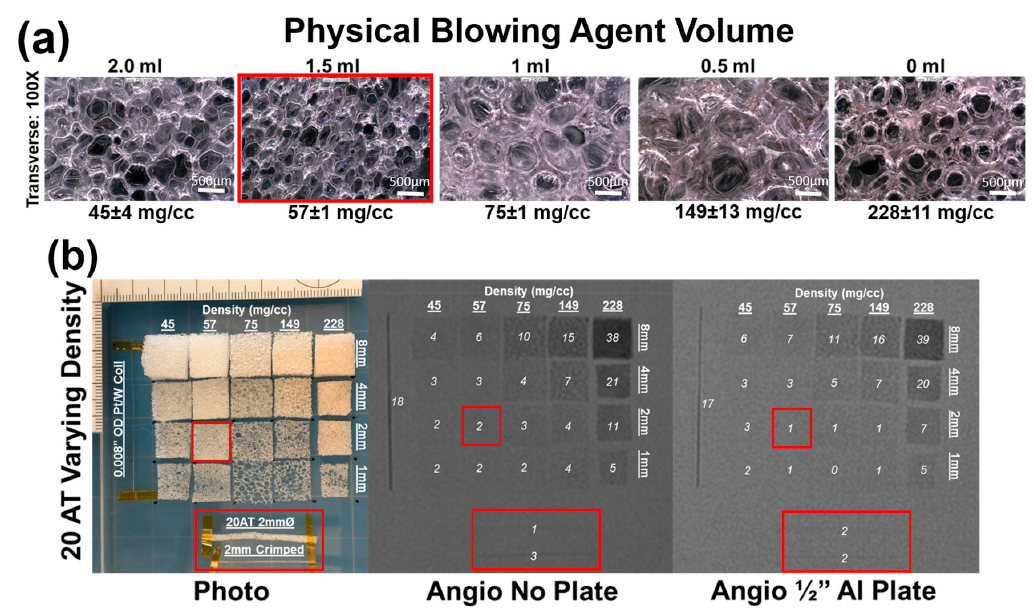
Figure 5. ( a ) Light microscopy images of foams with varying density at 100× magnification. Images are labeled with average ± standard deviation of density measurements ( n = 6); ( b ) Fluoroscopy images of 20% ATIPA foams with varying density at varying thicknesses. Neurovascular device prototypes and their corresponding foam formulation are boxed in red. A 92/8 Pt/W coil with 0.008 ′′ OD is included for comparison. Each sample is labeled with the average 8-bit decimal grayscale shift relative to the image background.